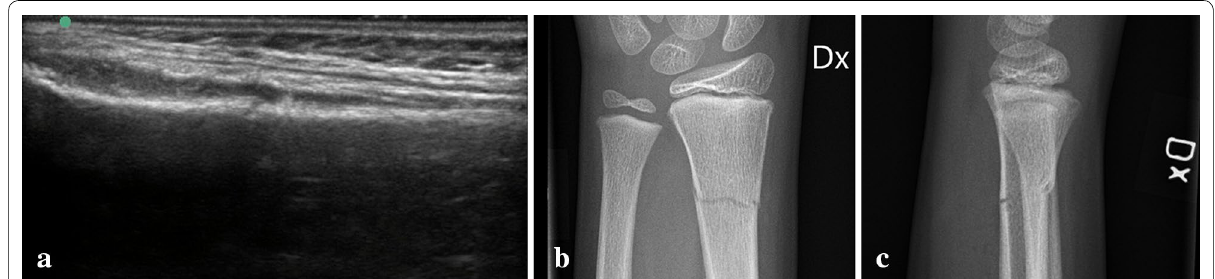
Fig. 3 a Complete non-displaced fracture of the distal radius. US volar longitudinal view. Note the discontinuous cortical line . b , c (Same case as a ) Complete non-displaced fracture of the distal radius on lateral and AP